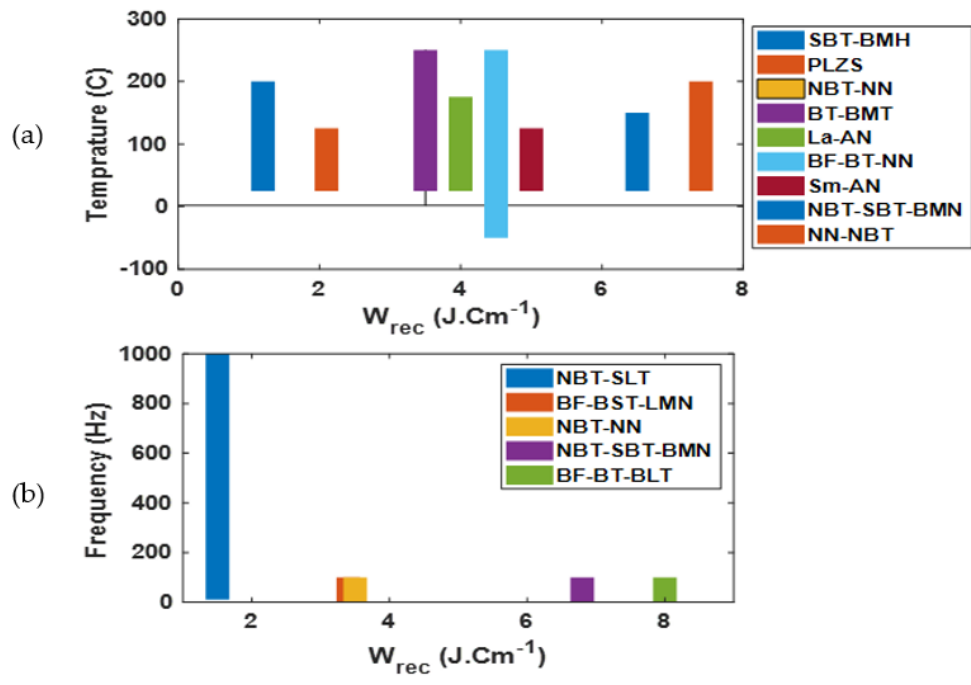
Figure 5. ( a ) Temperature [78] and ( b ) frequency-dependent [79] Wrec for some reported electro- ceramic materials for high-energy-density